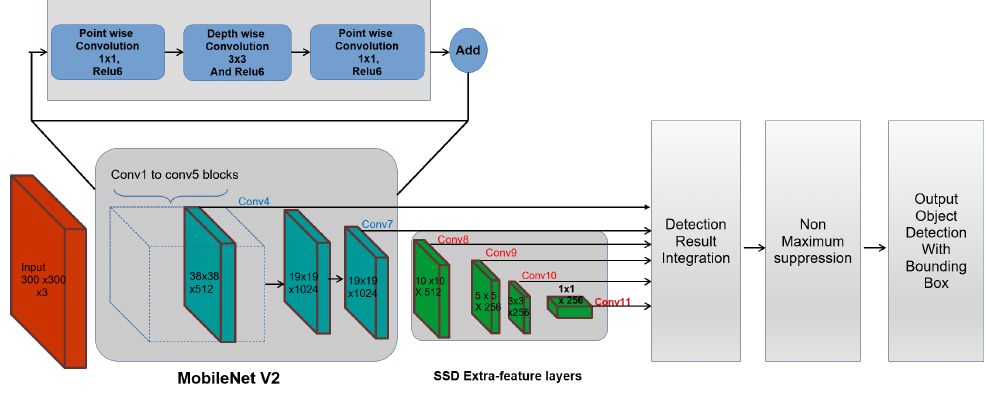
Figure 3. SSD MobileNet functional block